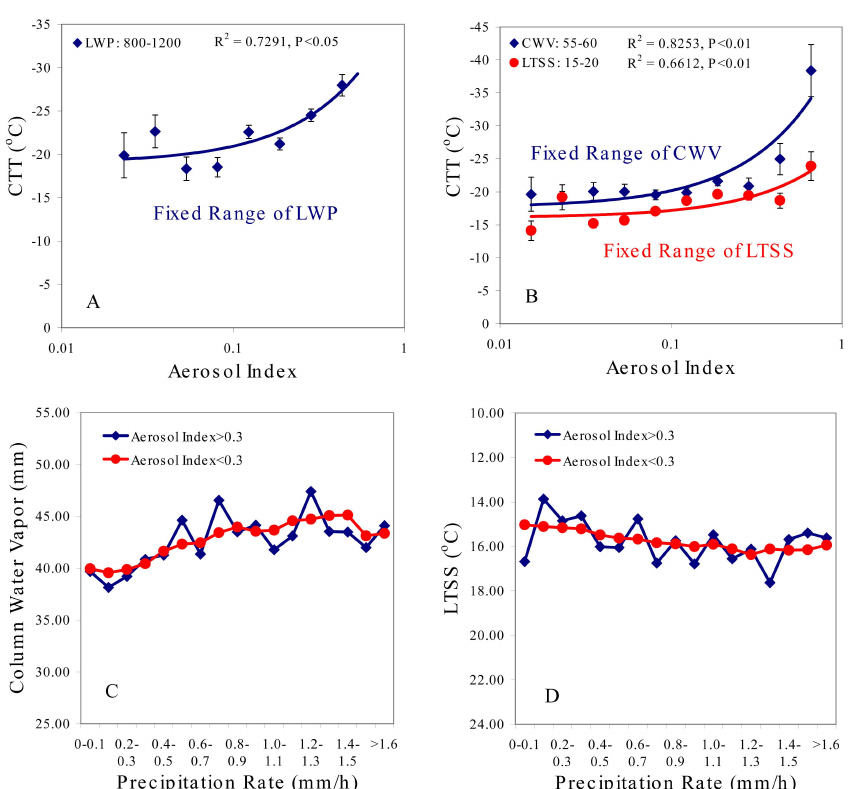
Fig. 5. Correlations between cloud-top temperature and AI under fixed ranges of LWP (A) , CWV and LTSS (B) for warm base mixed- phase clouds. The panels (C) and (D) show CWV and LTSS as functions of precipitation rate for polluted (AI > 0.3) and clean (AI < 0.3) atmospheric